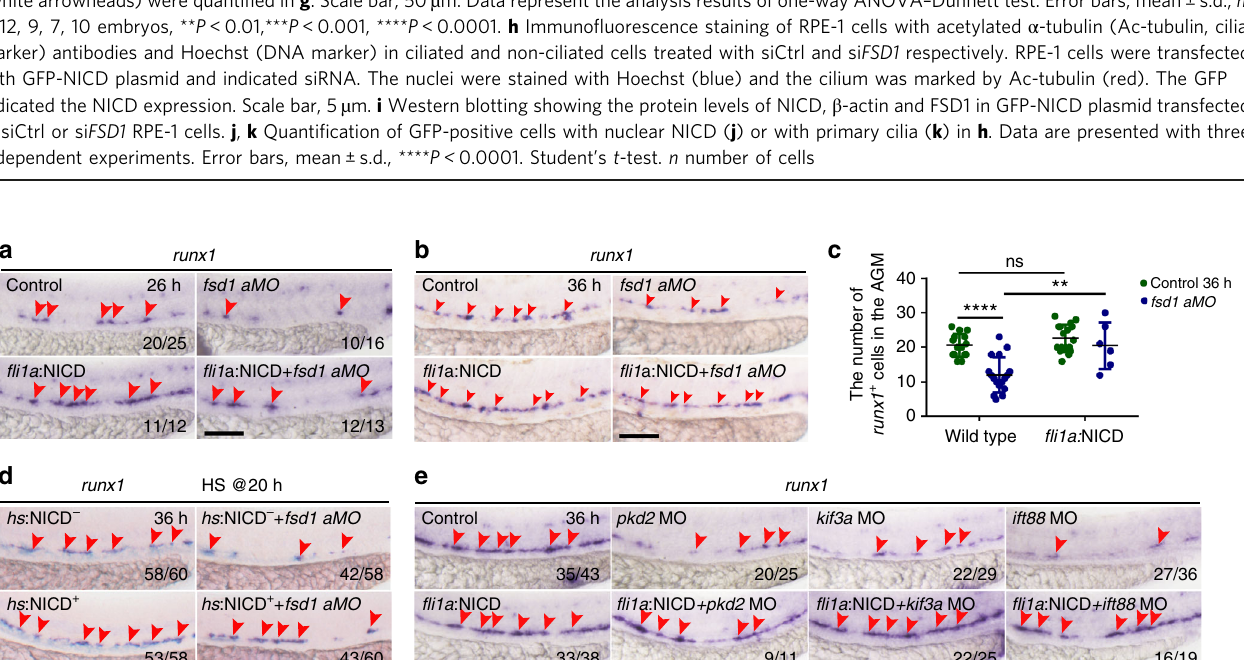
Fig. 7 Notch signaling acts downstream of primary cilia in regulating hematopoietic stem and progenitor cell (HSPC) speci fi cation. a , b Whole-mount in situ hybridization (WISH) result of runx1 expression in control embryos, fsd1 morphants, fl i1 a:NICD-EGFP plasmid-injected embryos, and fsd1 morphants injected with fl i1 a:NICD-EGFP plasmid at 26 hpf and 36 hpf. Red arrowheads denote the runx1 + cells in the AGM region. c Quanti fi cation of runx1 + cells in the aorta- gonad-mesonephros (AGM) region in b . Data represent the analysis results of two-way ANOVA – Tukey test for multiple comparisons. Error bars, mean ± s. d., n = 15, 17, 17, 6 embryos. ** P < 0.01, **** P < 0.0001. d WISH result of runx1 expression (red arrowheads) in control embryos, fsd1 morphants, hs :NICD- EGFP plasmid injected embryos, and fsd1 morphants injected with hs :NICD-EGFP at 36 hpf. These embryos were heat shocked for 30 min at 42 °C from 20 hpf. e Expression of runx1 (red arrowheads) in control, morphants, and fl i1a :NICD-EGFP injected morphants at 36 hpf. Scale bars, 100 µ Supplementary Table 1. The embryos were all natural spawning of adult zebra fi sh. This study was approved by the Ethical Review Committee in the Institute of Zoology, Chinese Academy of Sciences, Beijing, China.